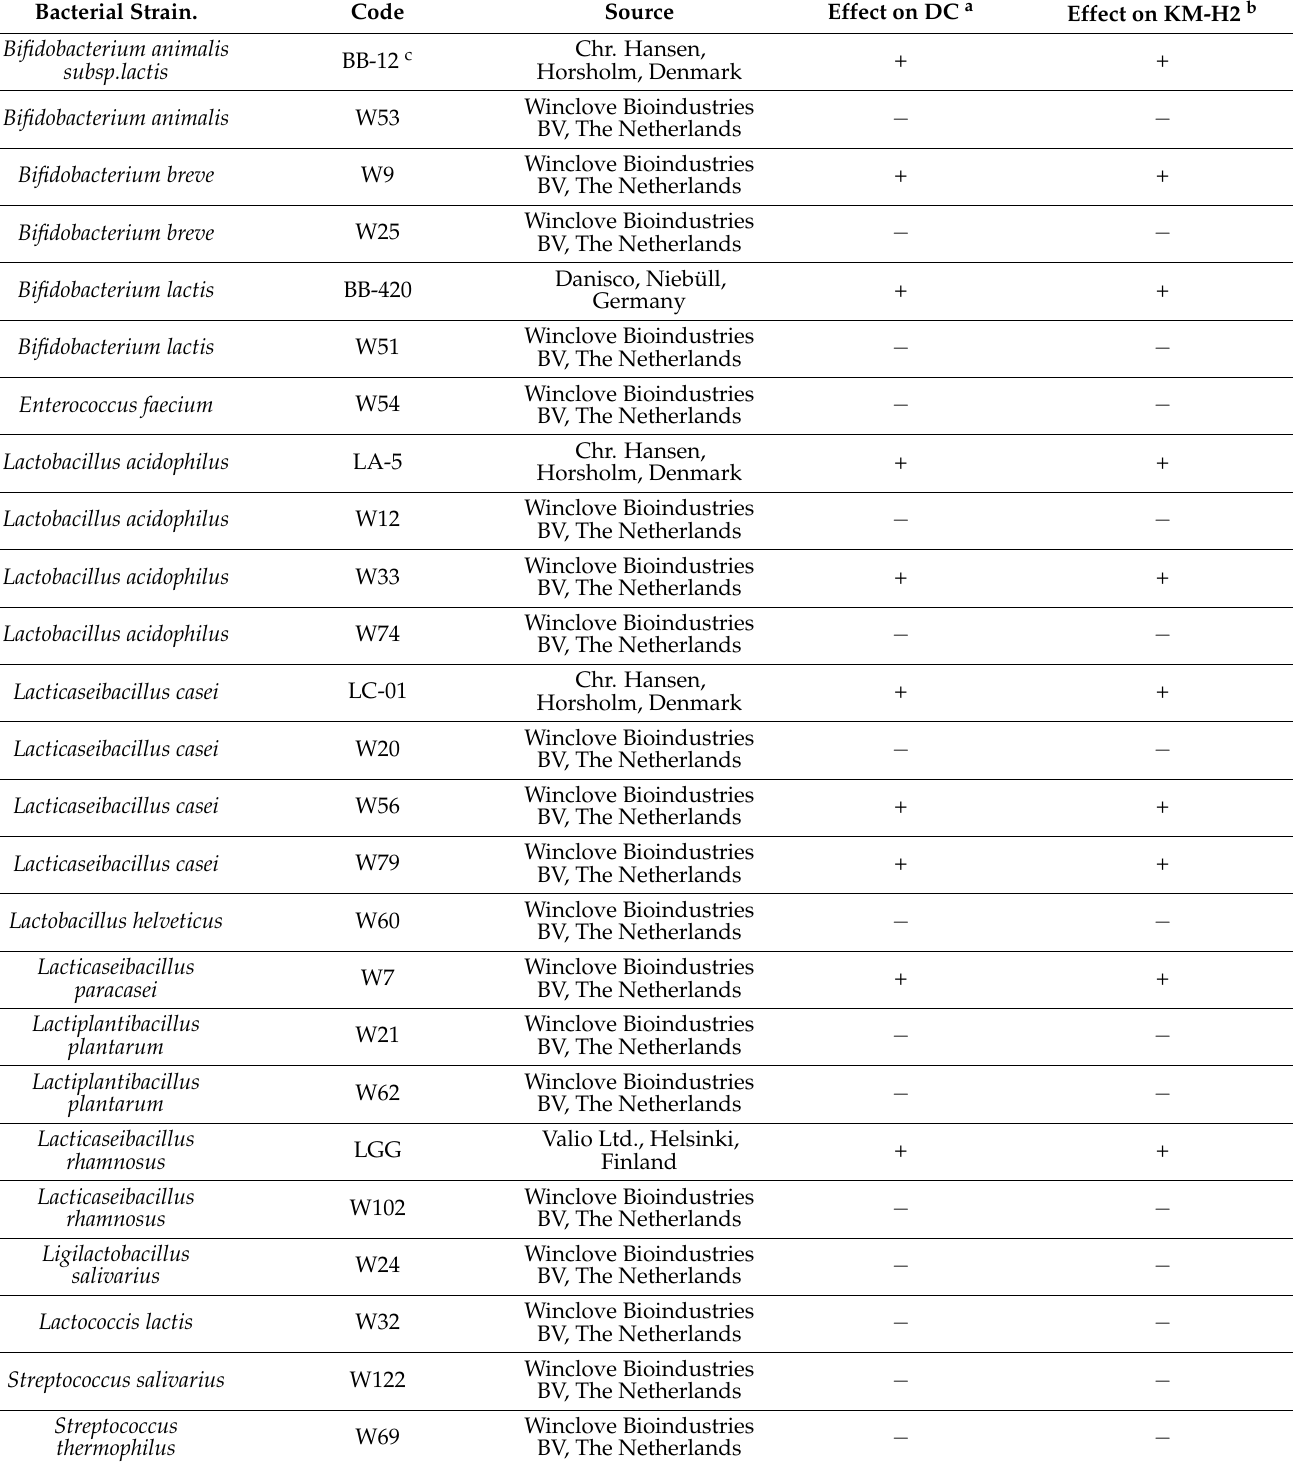
Table 1. Probiotic strain supernatants subjected to metabolite screening and their respective im- munomodulatory response previously observed in vitro. Bacterial